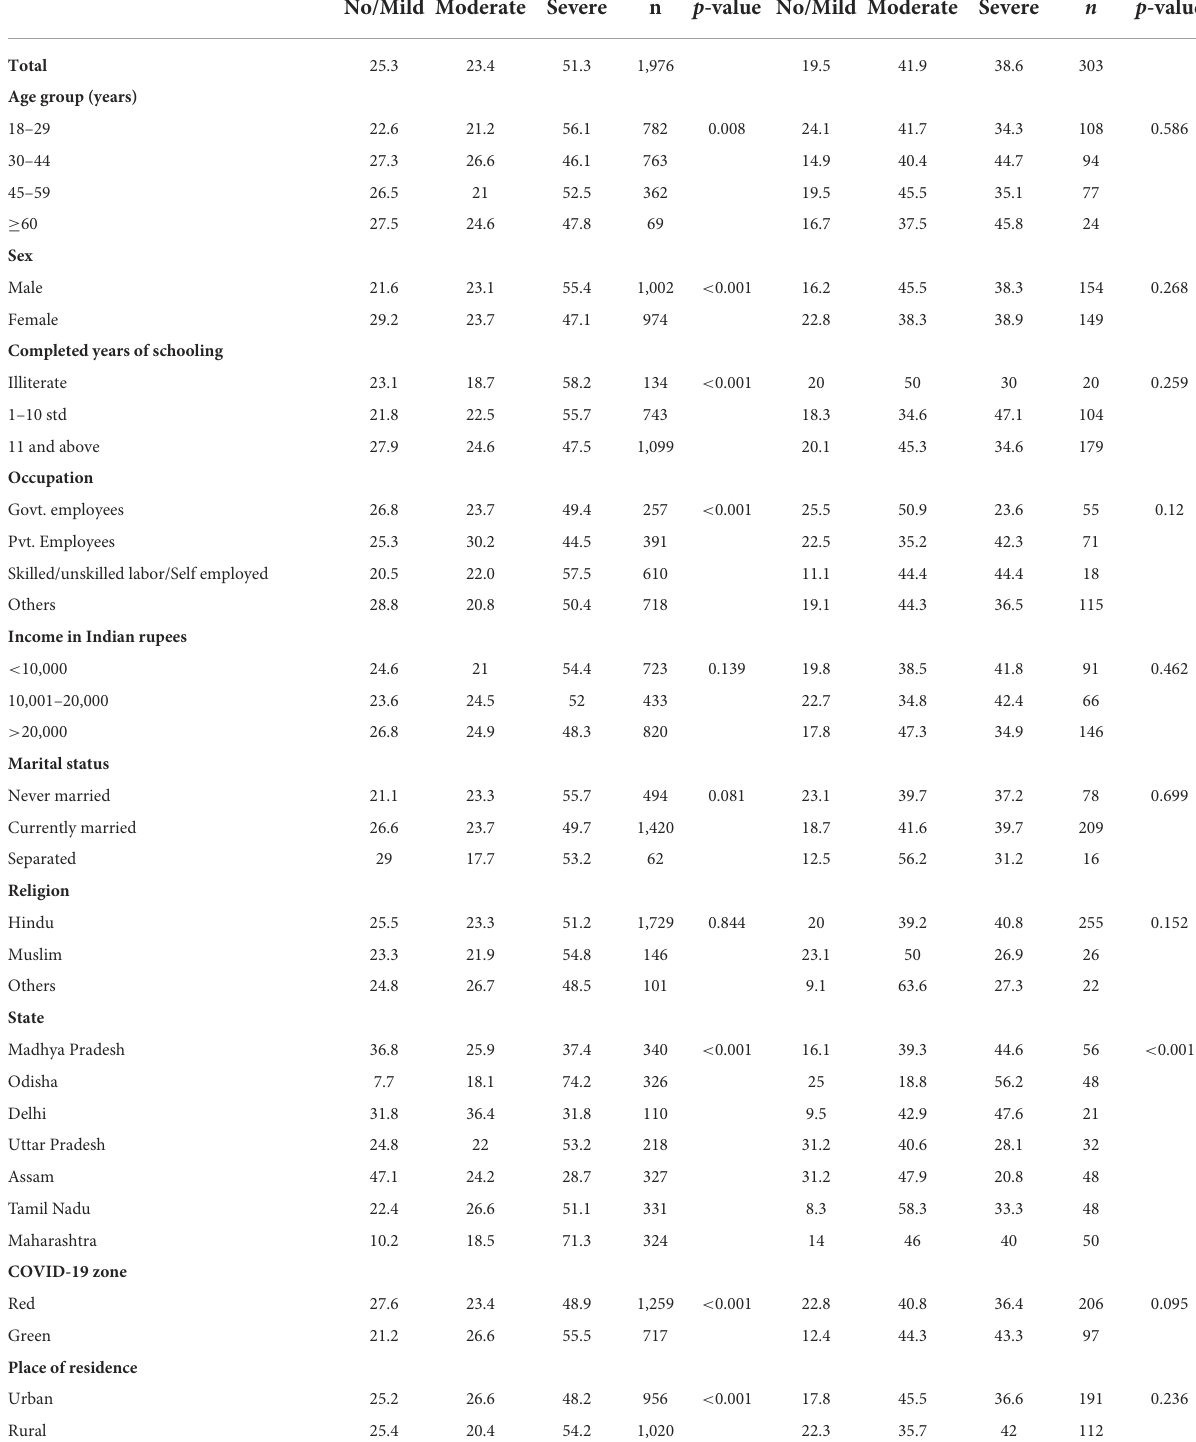
TABLE 2 Stigmatizing attitude among non-COVID-19 community participants and stigma experienced among COVID-19 recovered participants by selected variables (socio demographic, COVID-19 knowledge and risk perception) (bivariate analysis). COVID-19 stigmatizing attitudes Experienced COVID-19 stigma No/Mild Moderate Severe n p -value No/Mild Moderate Severe n p